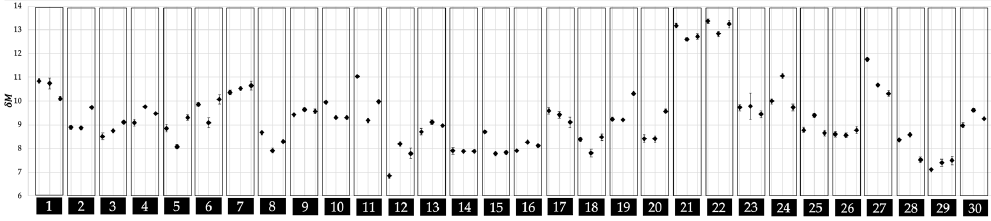
Figure 5. 𝛿 M mean of the morphing analysis with according standard deviations sorted by subjects.